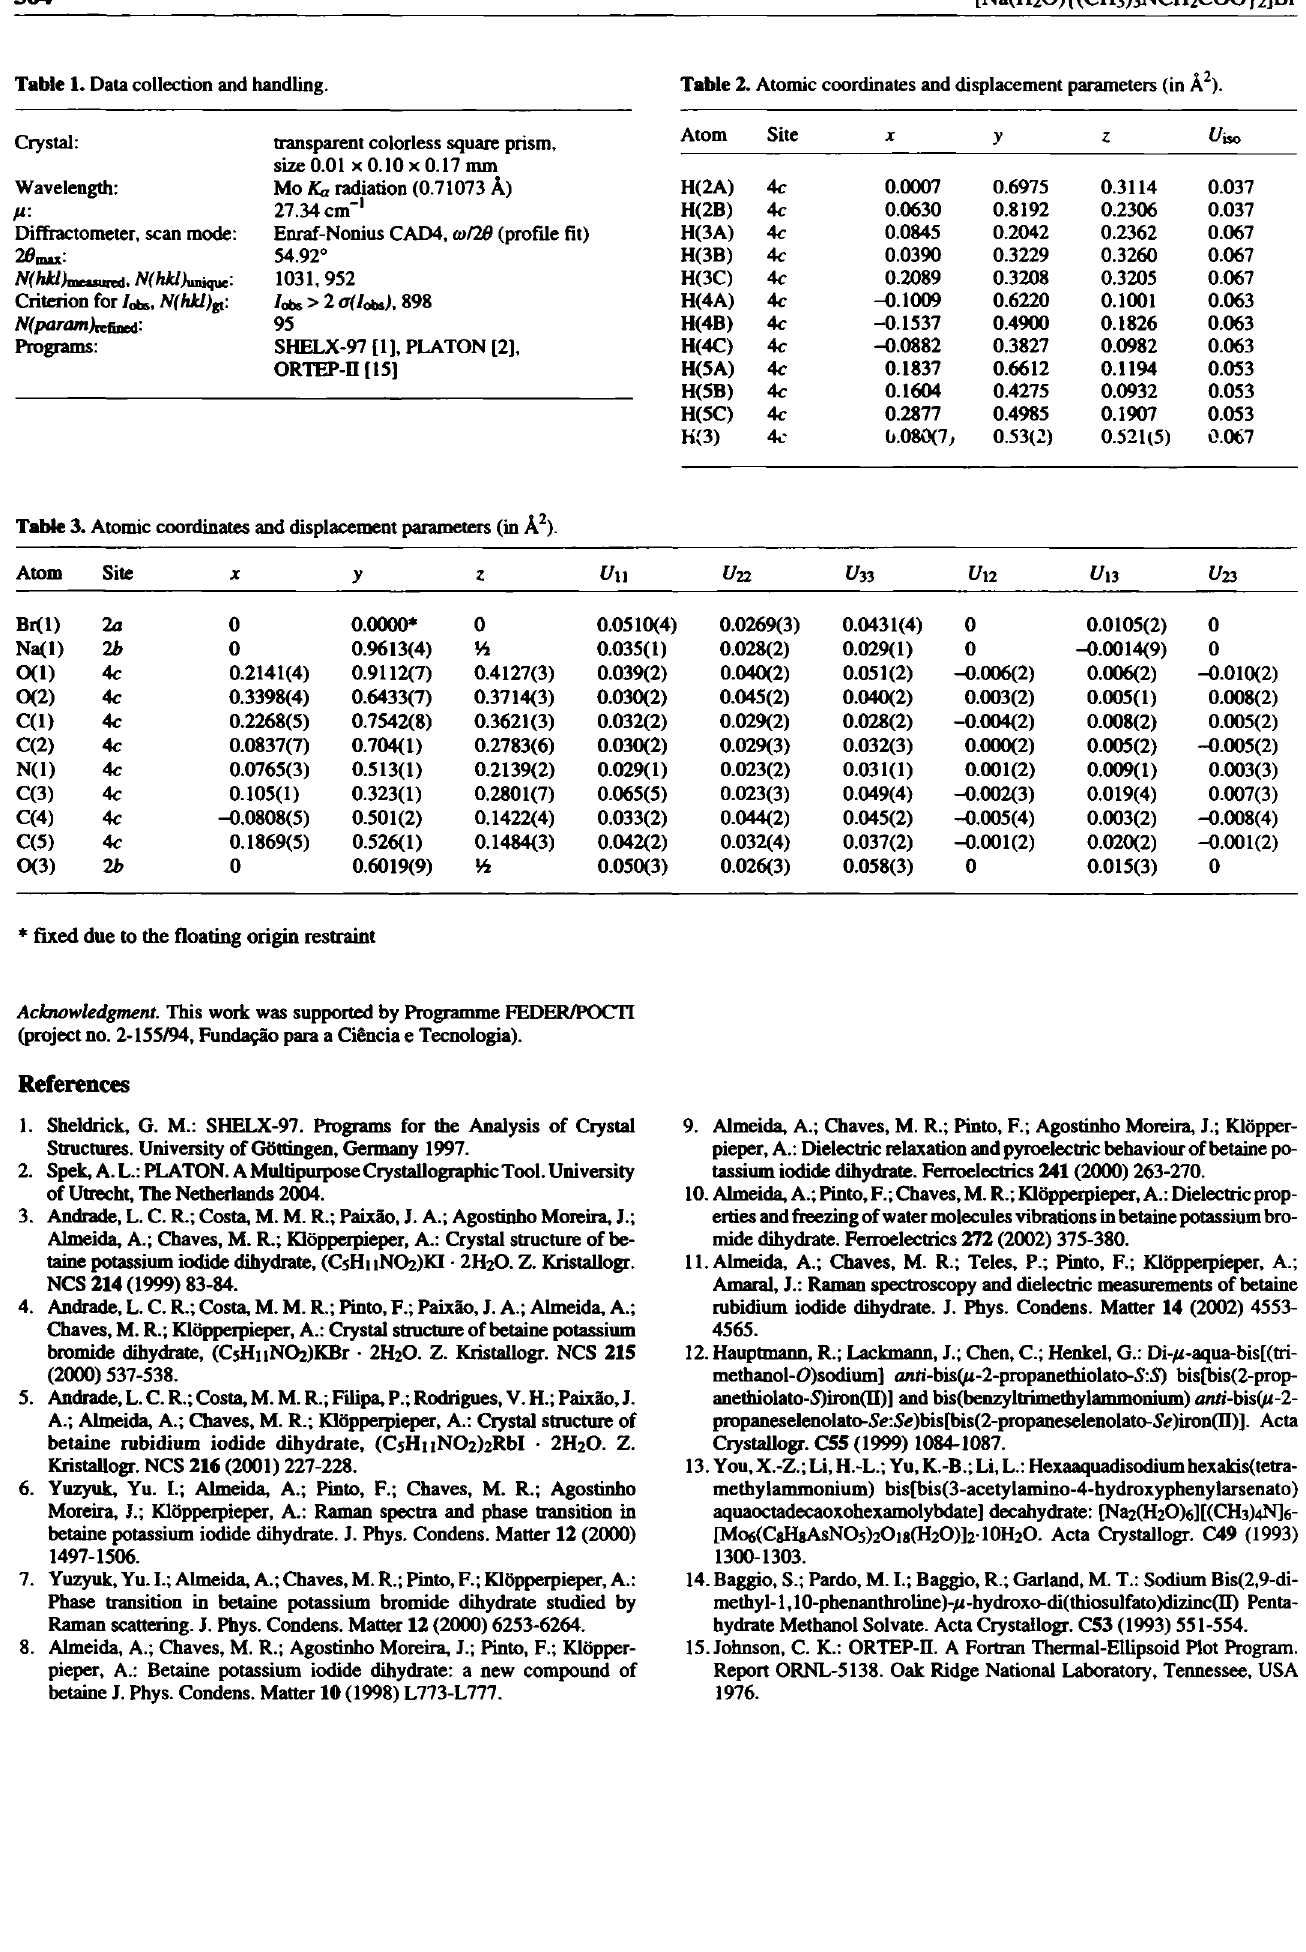
Table 1. Data collection and handling. Table 2. Atomic coordinates and displacement parameters (in A 2 ).